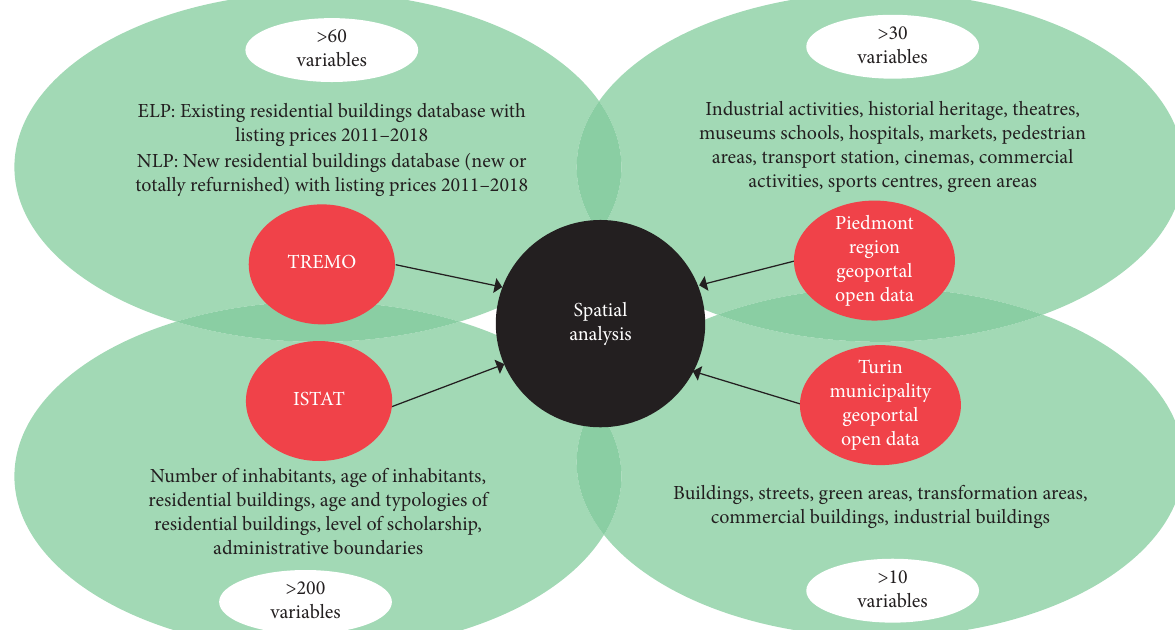
Figure 3: Multisources data for spatial analyses (source: authors’